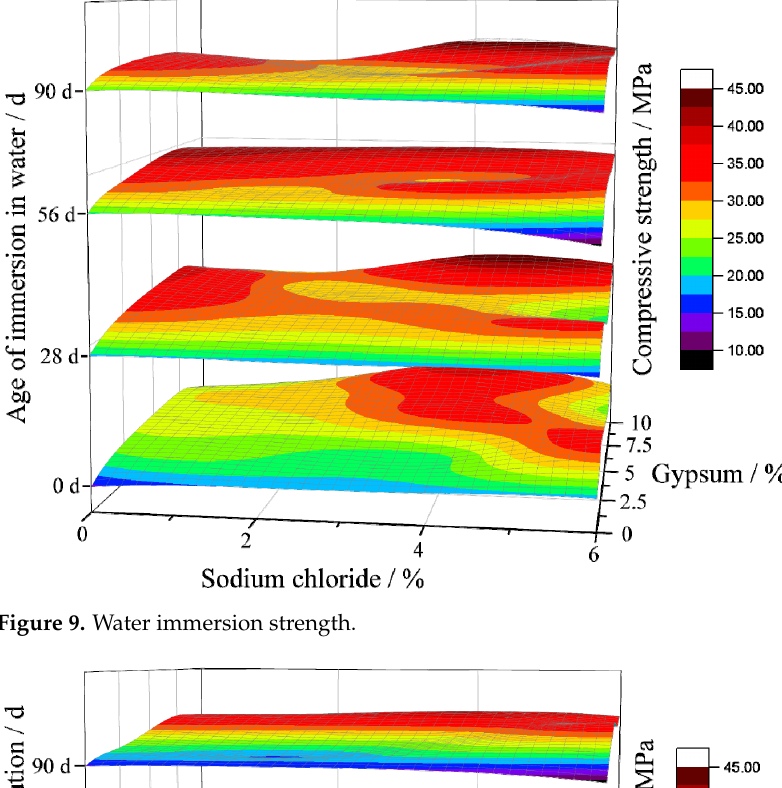
Figure 9. Water immersion strength.